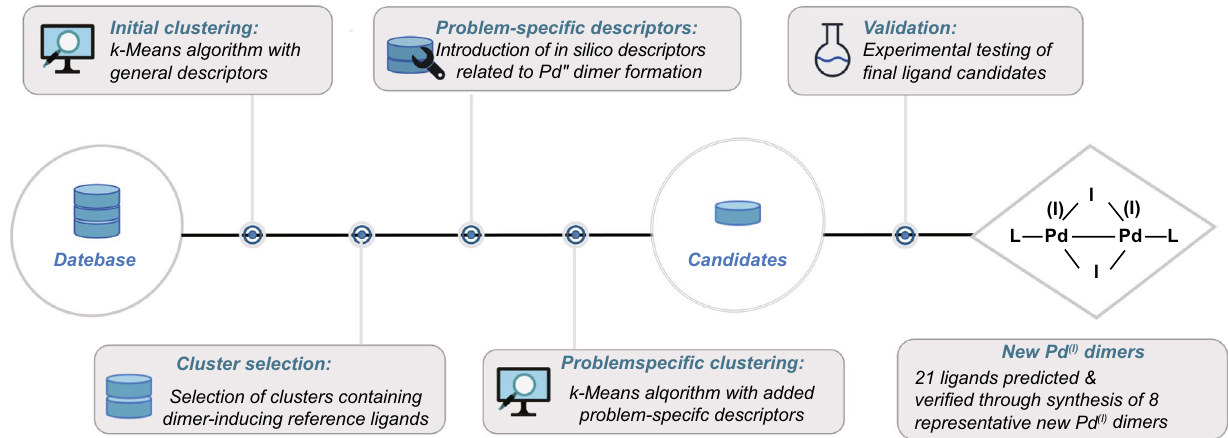
Fig. 8 Application of machine learning workflow to predict new Pd (I) dimers